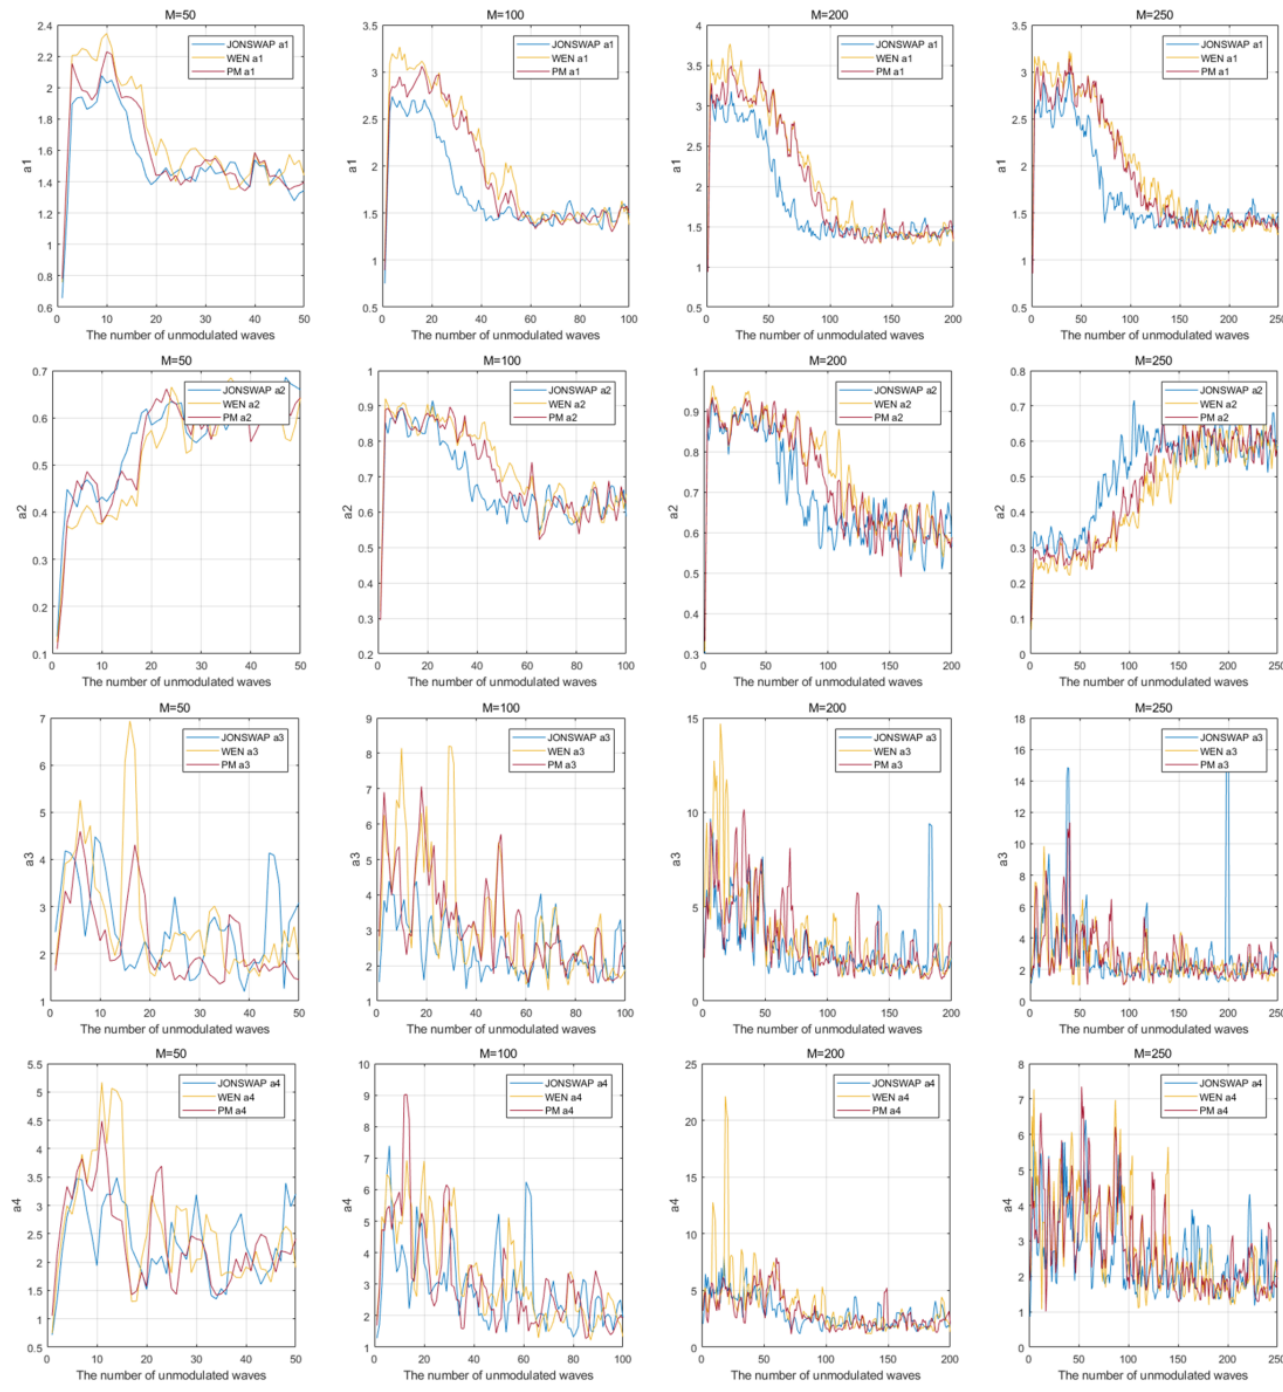
Figure 2. a1, a2, a3, a4 of freak waves generated by three wave spectra corresponding to different numbers of unmodulated waves under different numbers of constituent waves.